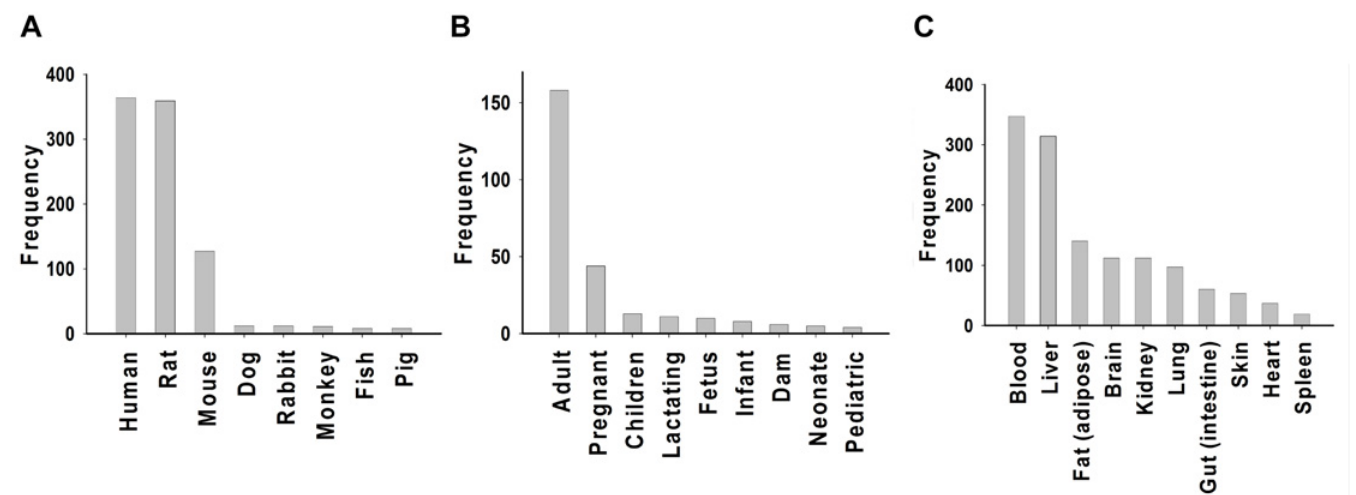
Fig 2. Keywords extraction from PBPK literatures. The abstracts in the PBPK knowledgebase were analyzed to identify PBPK-associated word-stems: (A) Frequency of the top 10 species; (B) Frequency of the top 10 life stages; (C) Frequency of the top 10 compartments.